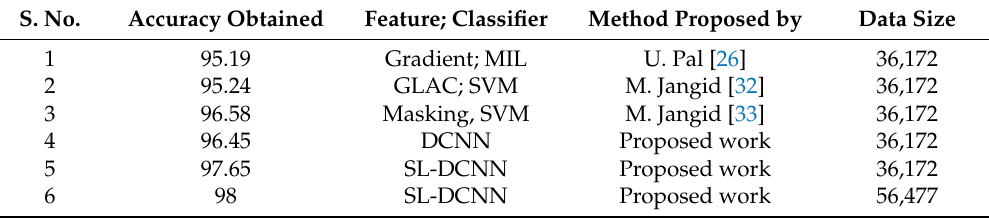
Table 7. Comparison of recognition accuracy by other